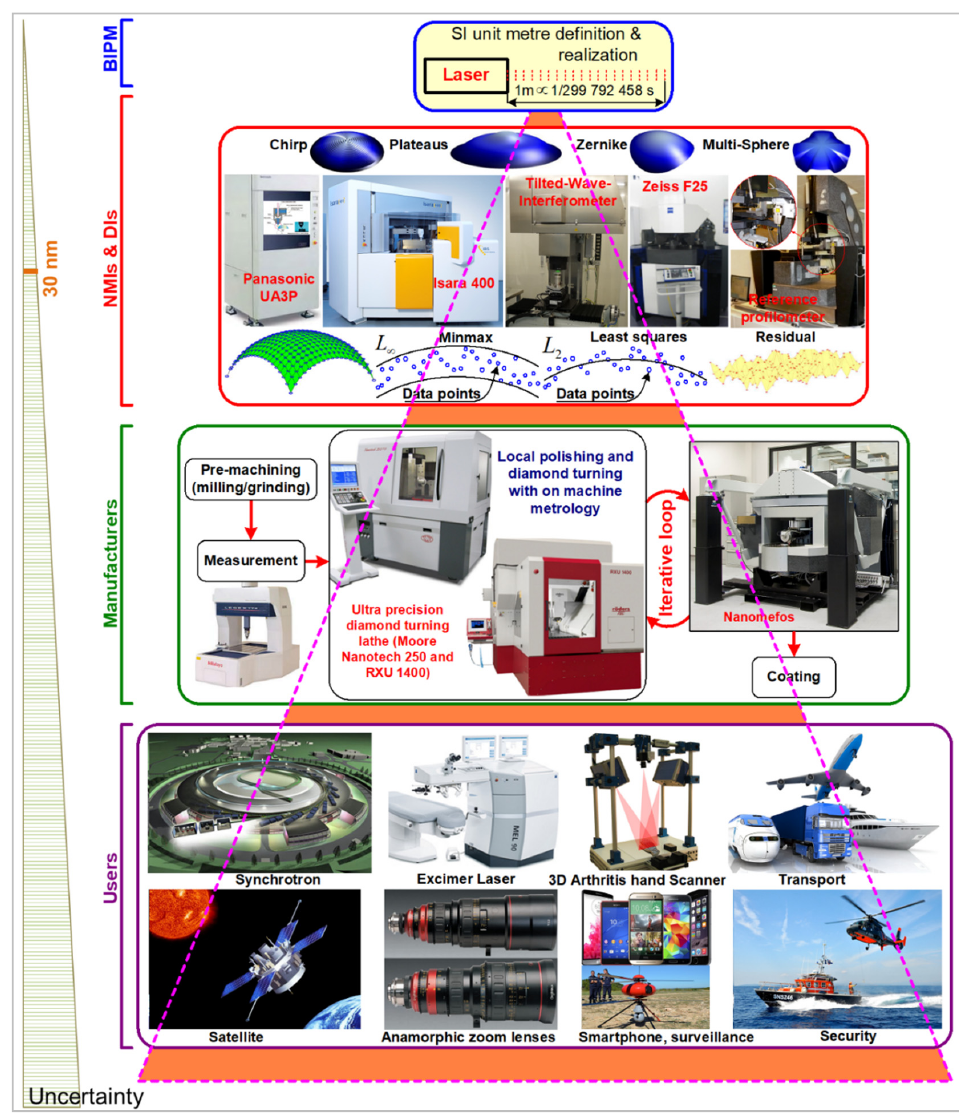
Figure 2. Description of the traceability chain in asphere and freeform metrology. The SI unit meter definition is estab- lished at the BIPM (International Bureau of Weights and Measures) by experts from NMIs (National Metrology Institutes) and DIs (Designated Institutes), materialised at NMIs and DIs and shared to manufactures and end users with respect to a pyramid organization.